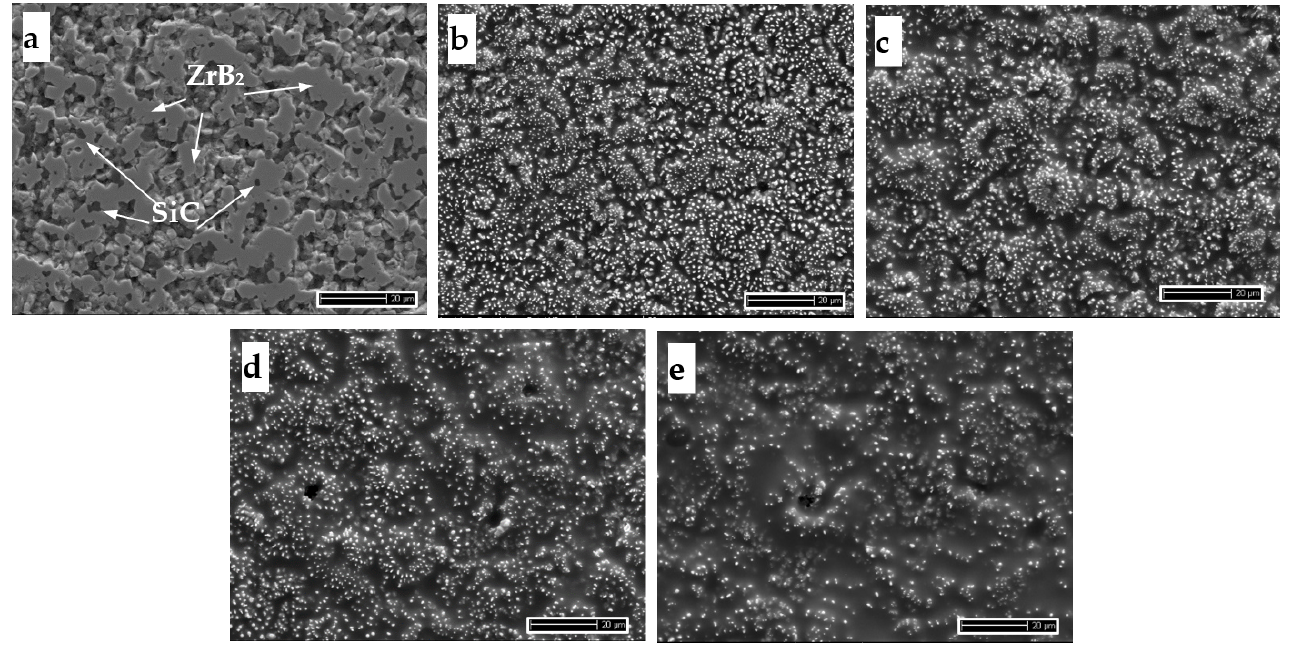
Figure 1. Micrographs of the original specimen ( a ) and the specimens shocked with 10 ( b ), 20 ( c ), 30 ( d ), and 50 ( e ) cycles. The scale of the images is 20μm. In ( a ), ZrB 2 is gray and the SiC is a dark color in the